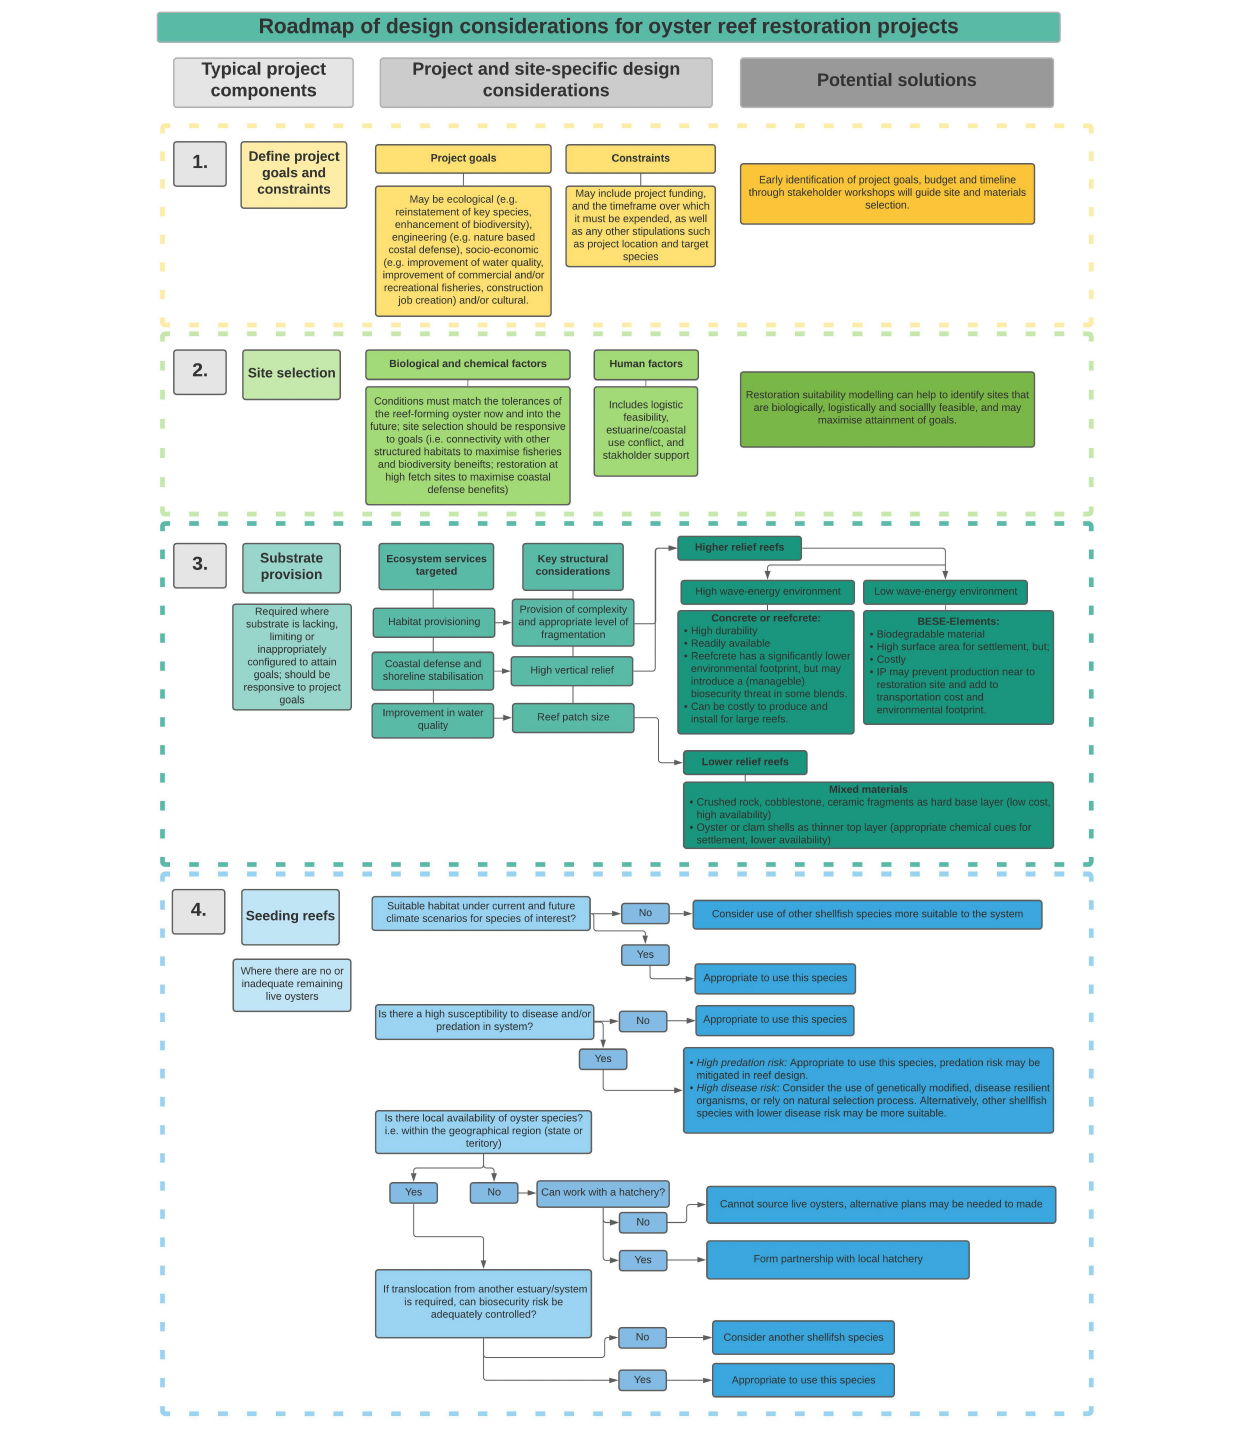
FIGURE 2 | Contemporary roadmap of design considerations for oyster reef restoration projects.